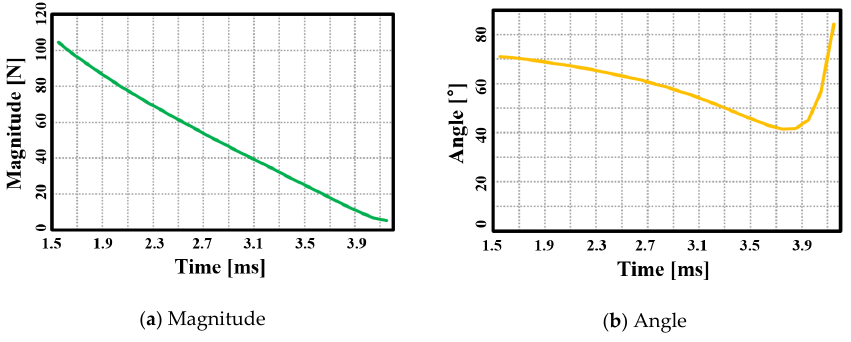
Figure 9. The combined force of the hot gas force and the Lorentz force.